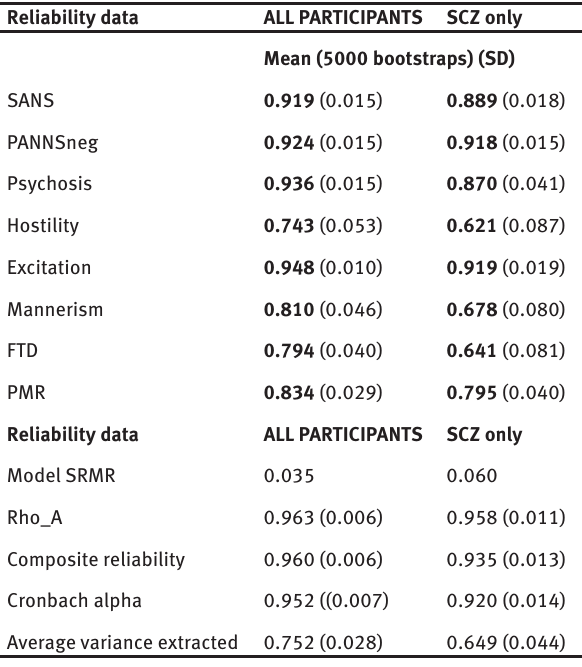
Table 6: Results of Partial Least Squares analysis Reliability data